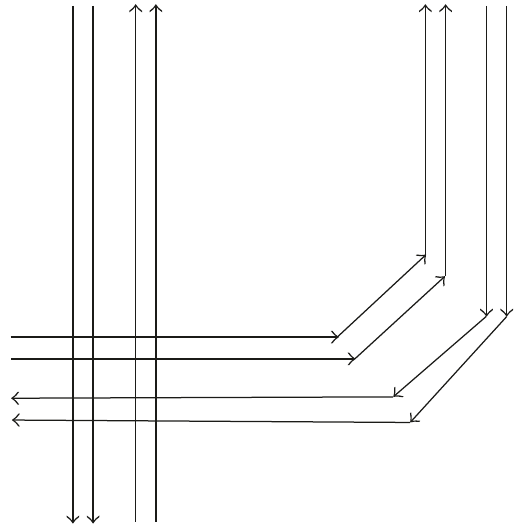
Figure 4: Example of node movement in the Freeway